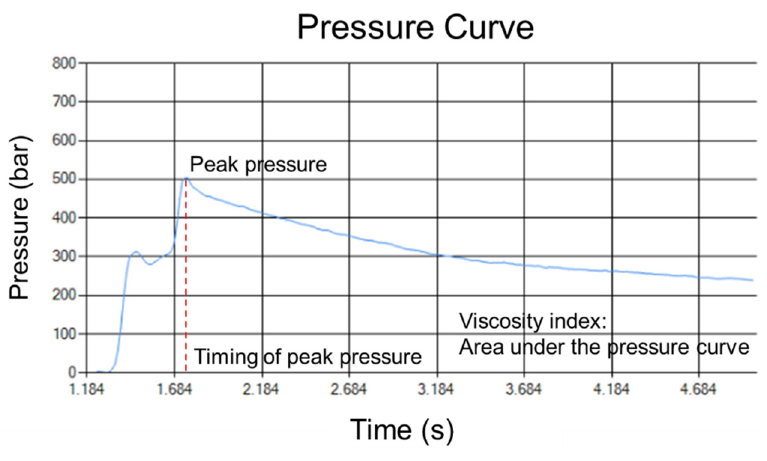
Figure 3. Pressure curve